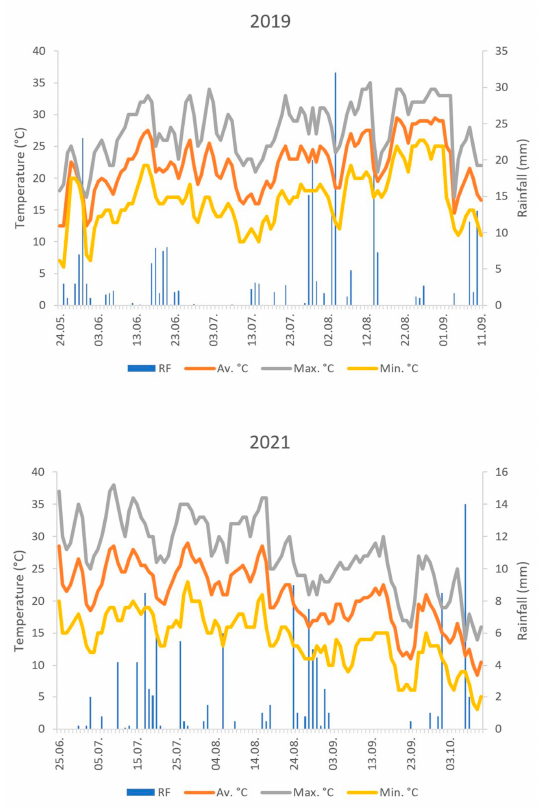
Figure 1. Daily maximum (Max.), minimum (Min.), and average (Av.) air temperature and rainfall (RF) data for the growing seasons 2019 and 2021.